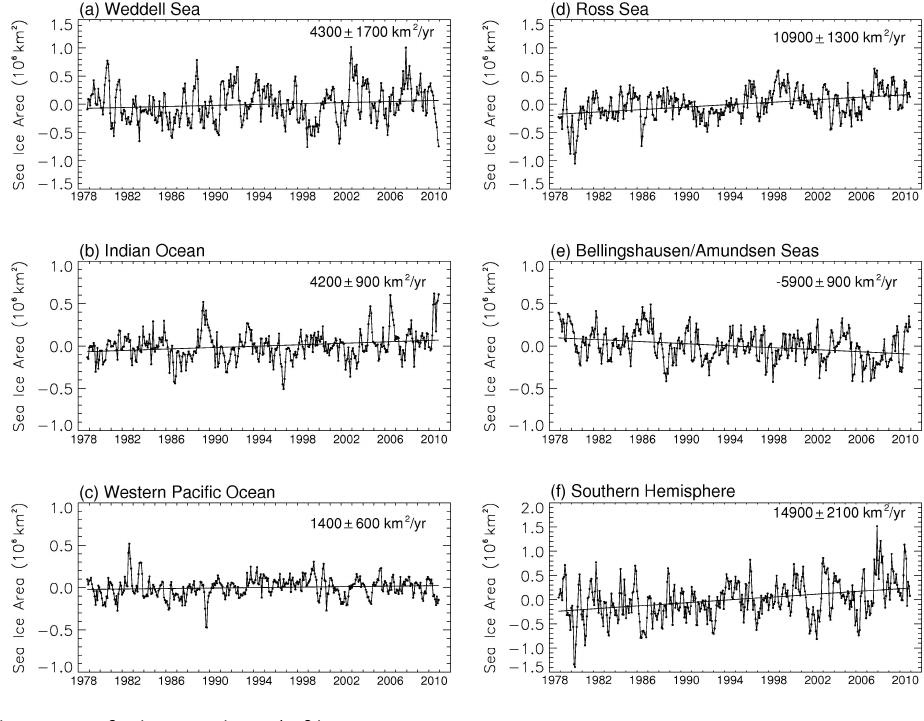
Fig. 7. Same as Fig. 4 except for ice areas instead of ice extents.